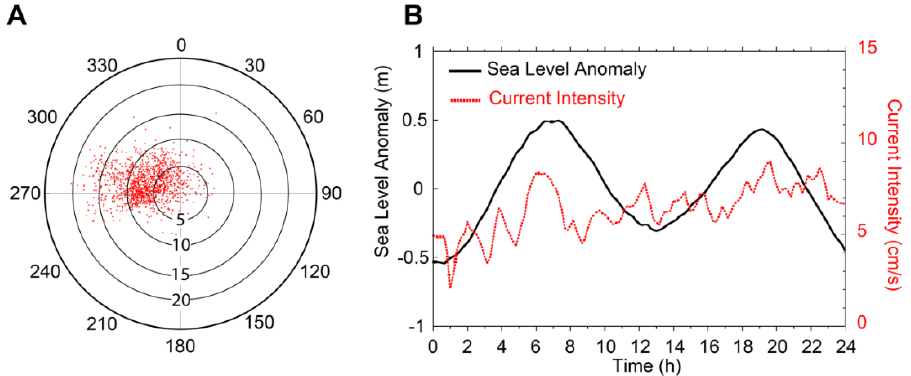
Figure 12. ( A ) Scatter plot of the short term current meter data from December 2 to December 10, 2019; and ( B ) average daily sea-level anomaly and current intensity along the mean current direction.